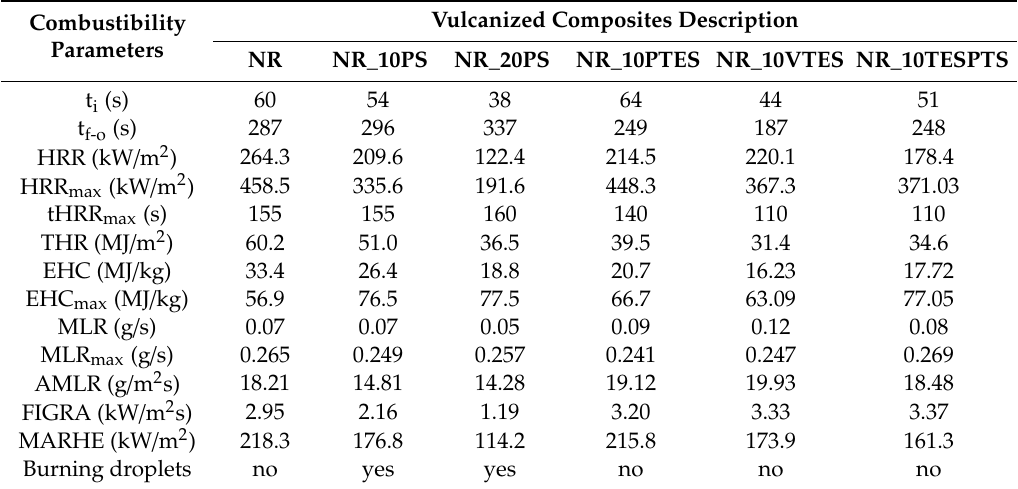
Table 7. Flammability results of composites containing unmodified and modified natural